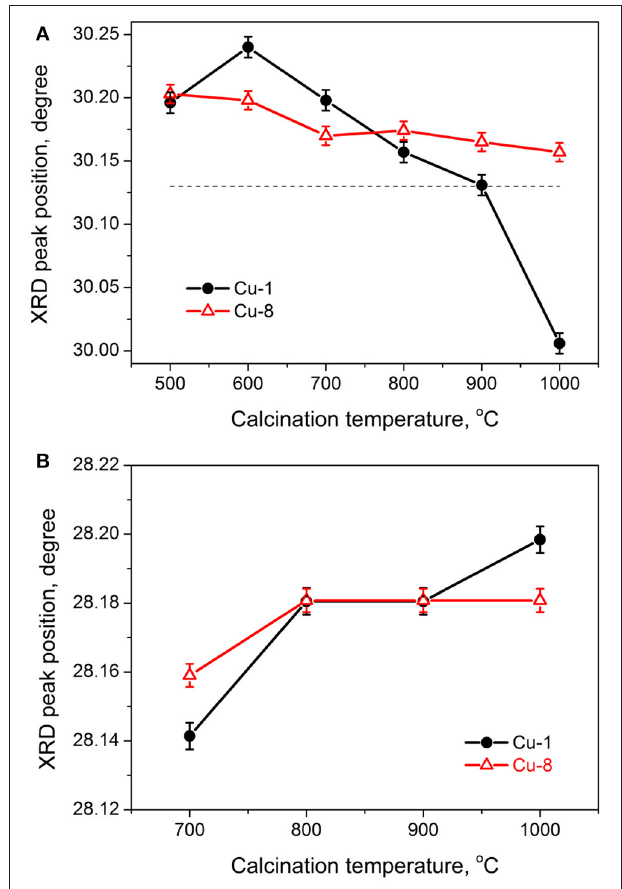
FIGURE 3 | Evolution of XRD peak positions of tetragonal (A) and monoclinic (B) phases with calcination temperature. Dashed line in (A) shows the tabled XRD peak position of tetragonal phase of ZrO 2 -3mol% Y 2 O 3 powder